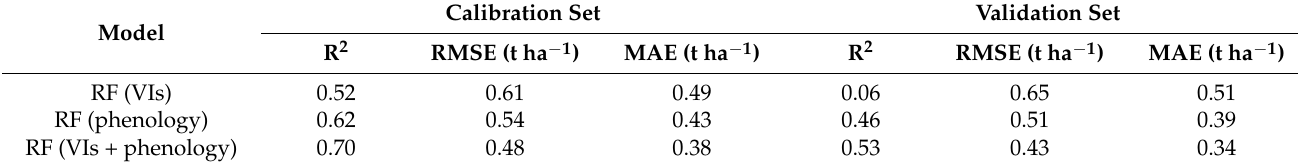
Table 6. Statistics of RF models for yield estimation in calibration (747 plots in 2017 and 2018) and validation (315 plots in 2019) sets.